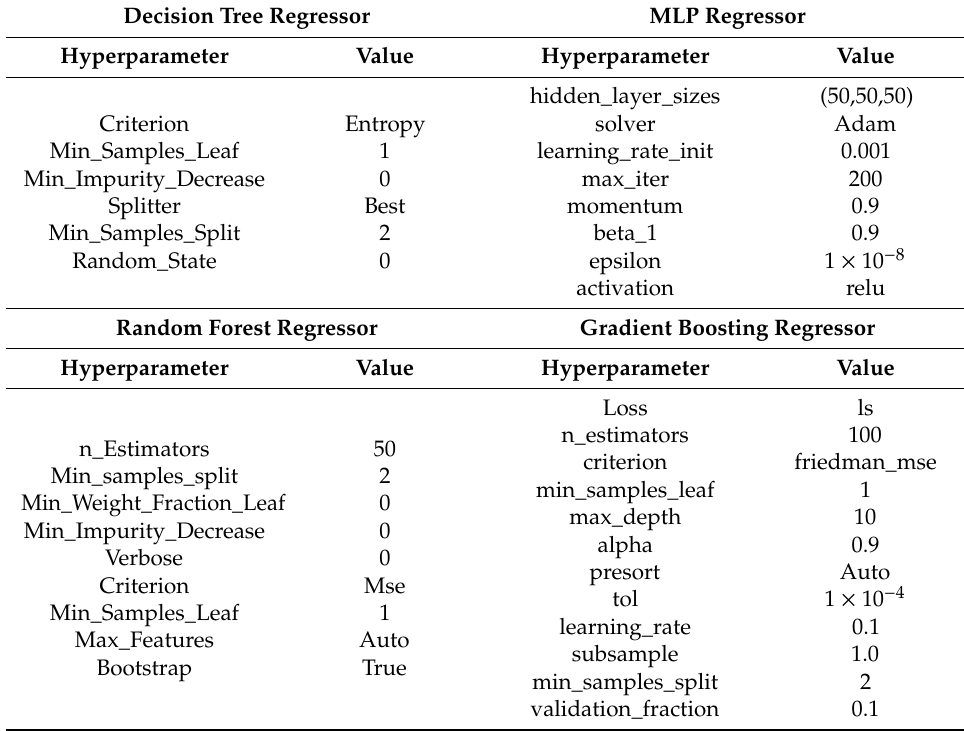
Table 3. The critical hyperparameters in nonlinear regression machine learning algorithms. Decision Tree Regressor MLP